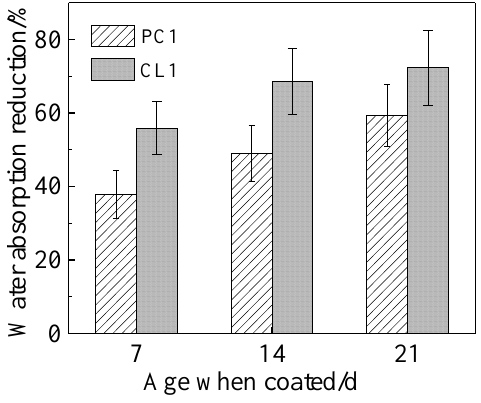
Figure 4. Rate of 48-hwater absorptionin specimens.